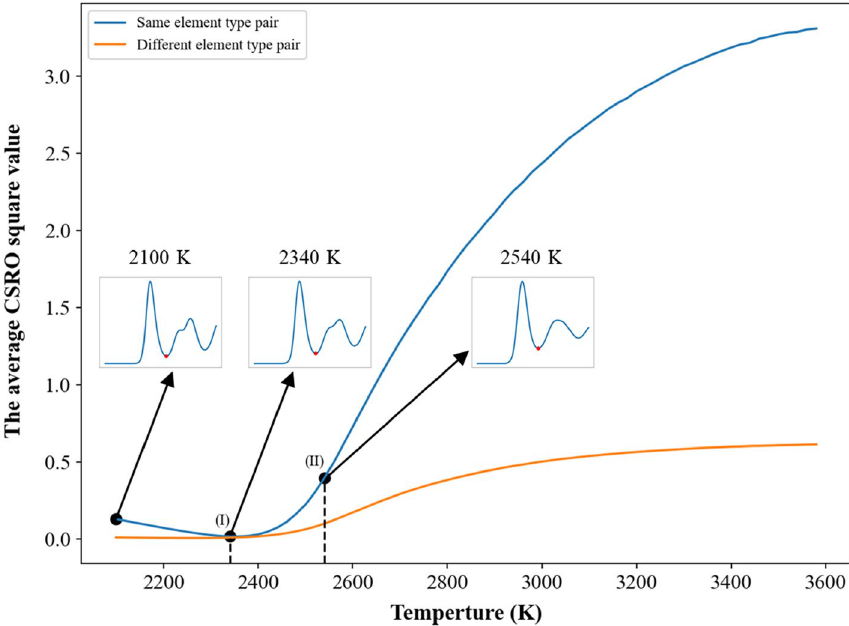
Figure 16. Average CSRO square profiles of the same and different element type pairs for the Nb